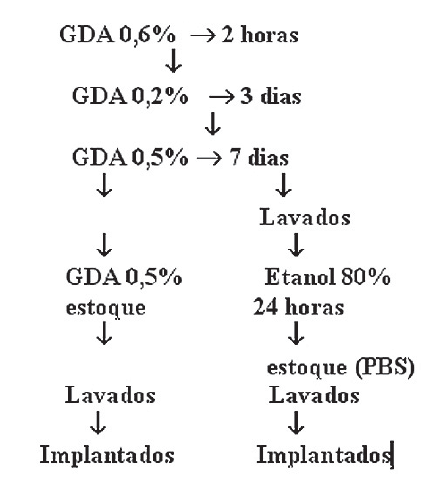
Fig. 2 - Processo químico